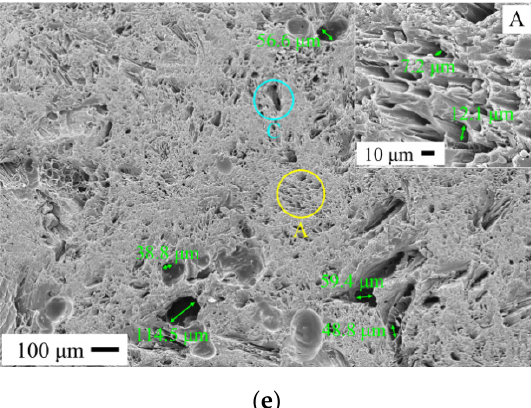
Figure 7. SEM micrographs of C WCMs with different resin concentration under a constant filling rate of wood powder of 37.5%: ( a ) resin concentration = 20%; ( b ) resin concentration = 30%; ( c ) resin concentration = 40%; ( d ) resin concentration = 50%; ( e ) resin concentration = 60%.